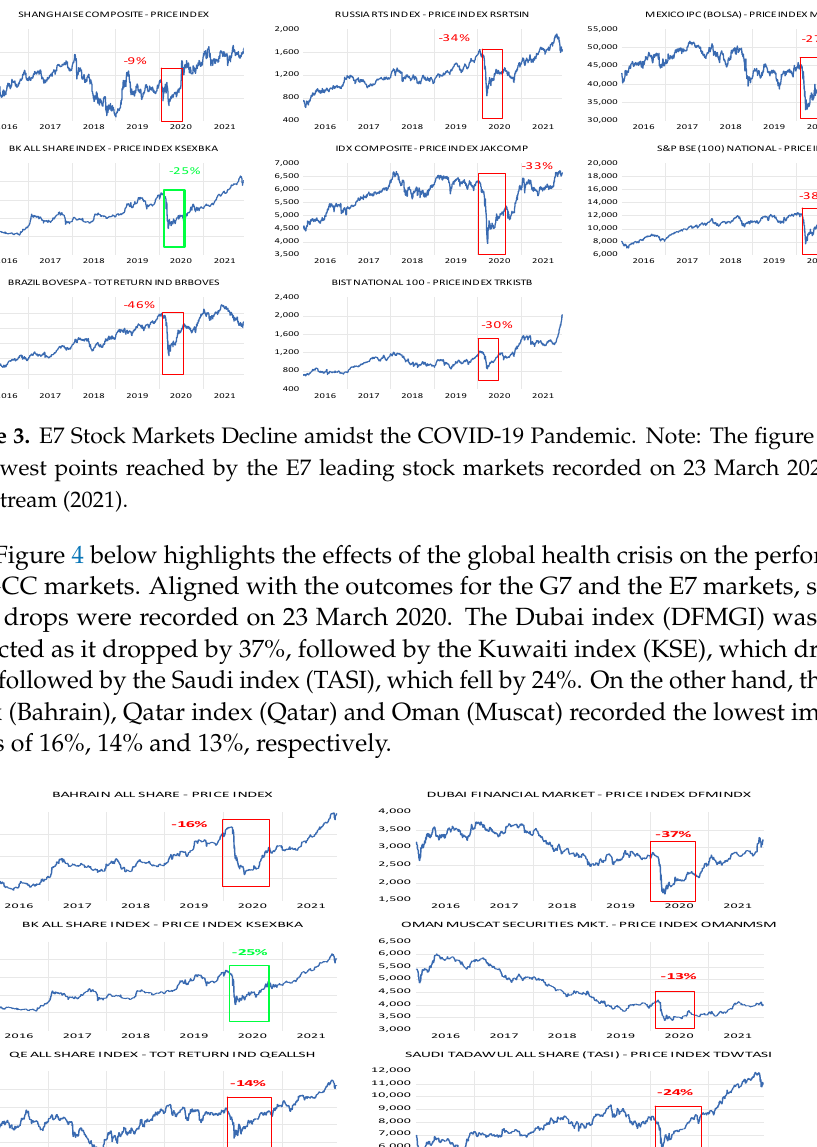
Figure 4. G.C.C. Stock Markets Decline amidst the COVID-19 Pandemic. Note: The figure highlights the lowest points reached by the GCC leading stock markets, which were recorded on 23 March 2020. Source: DataStream (2021). Kuwait stock exchange, as Al-Kandari and Abul (2020) studied the impact of the regula- tory changes in the Kuwait stock exchange in terms of volatility. They applied ARCH,